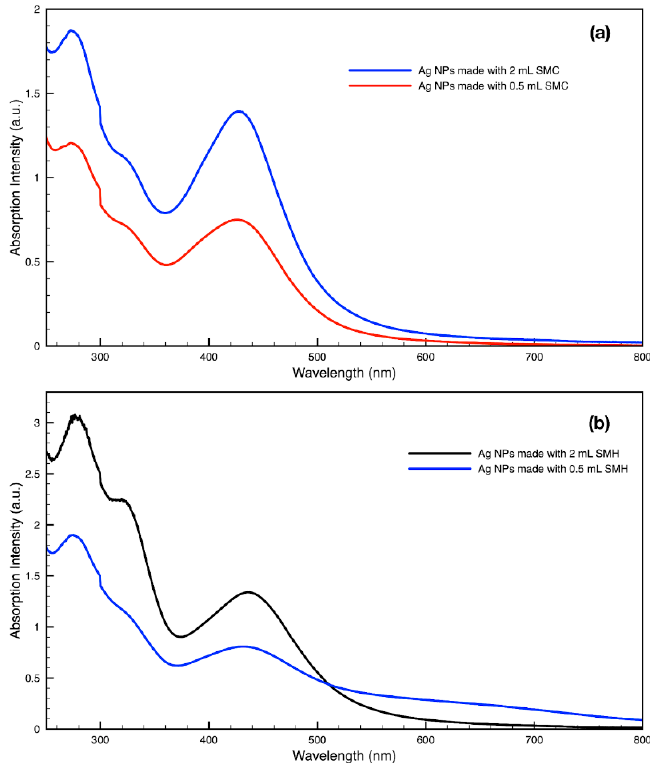
Figure 13. Absorption spectra of silver (Ag) nanoparticles (NPs) synthesized with either 2 mL or 0.5 mL of ( a ) SMC extract or ( b ) SMH extract per 30 mL sample.